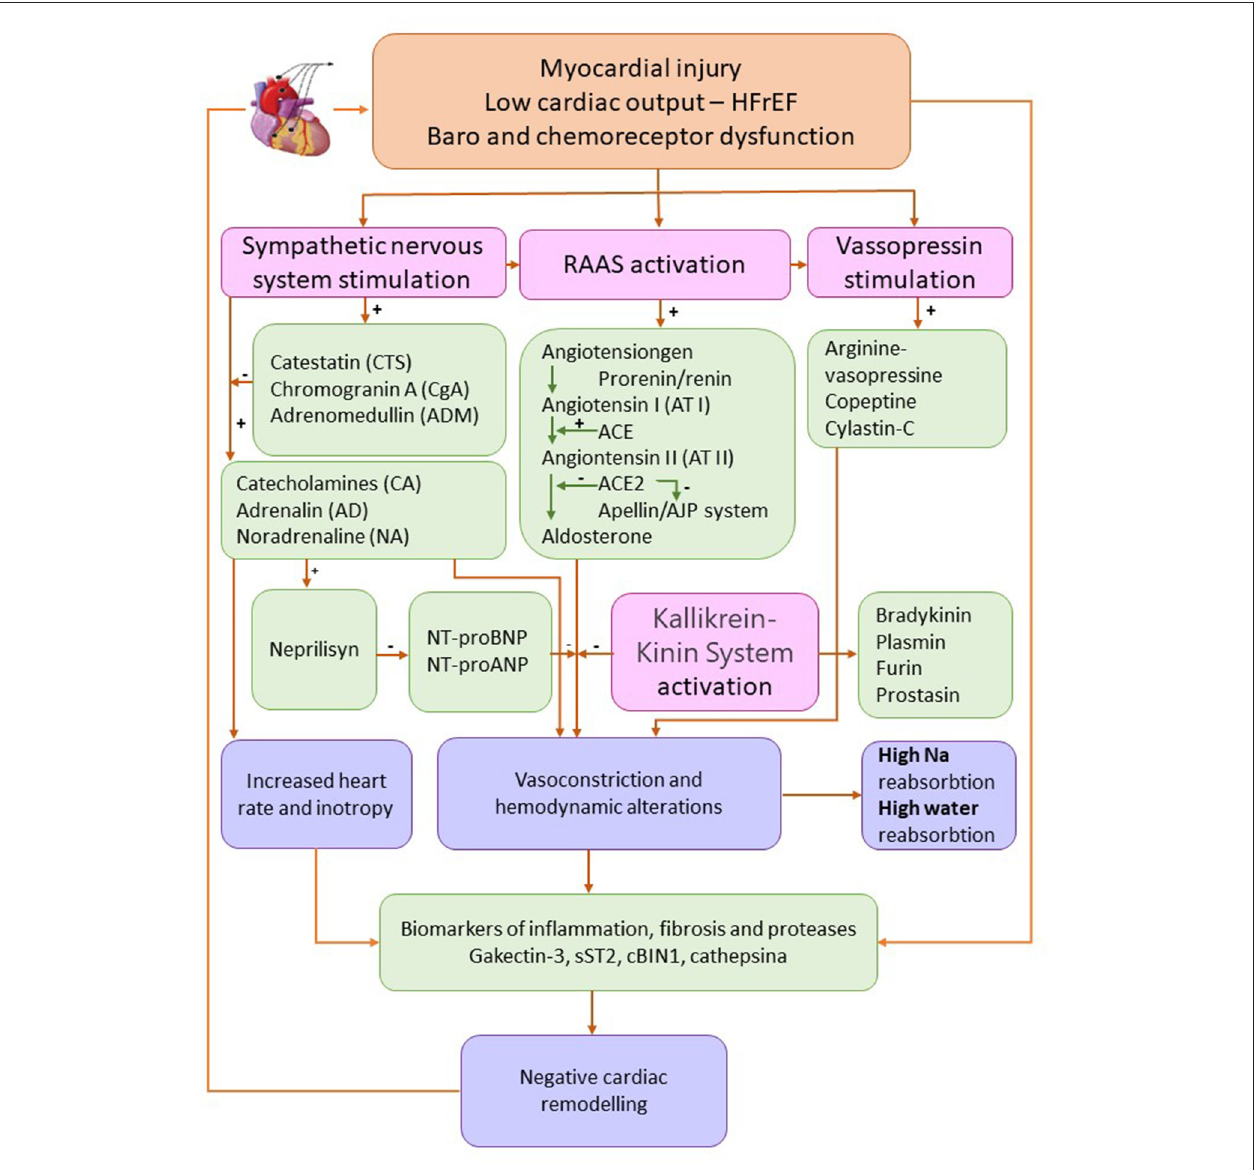
FIGURE 2 | Biomarkers of different physiopathological pathways responsible for volume overload and edema heart failure with reduced ejection fraction. Adapted from Ibrahim et al. (84) and Oikonomou et al. (91) (HFrEF, heart failure with reduced ejection fraction; Na, sodium; RAAS, renin-angiotensin-aldosterone system).